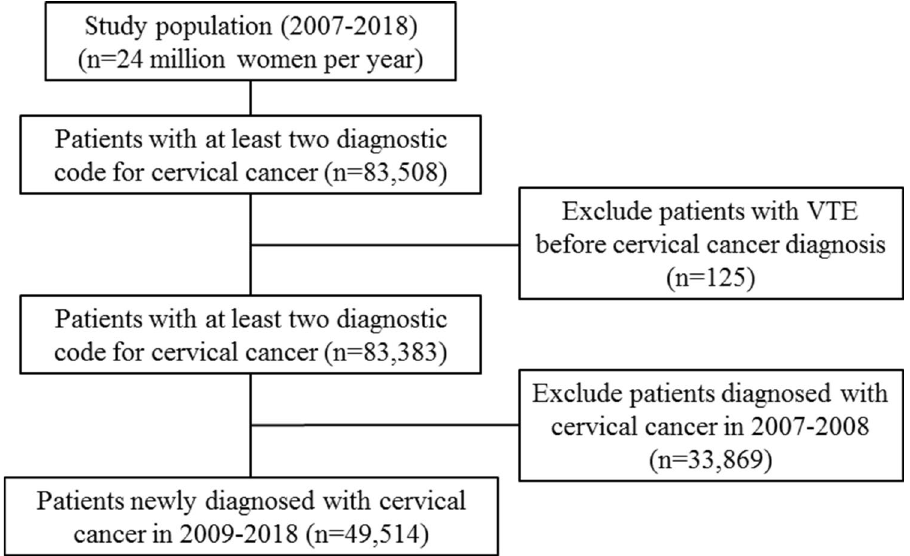
Figure 1. Flow chart for extracting patients included in the study. VTE, venous